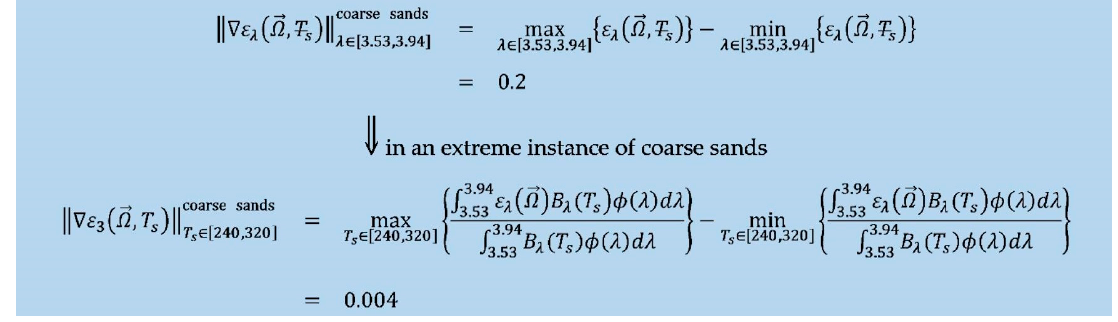
→ Ω , T s ) on NOAA/AVHRR channel 3